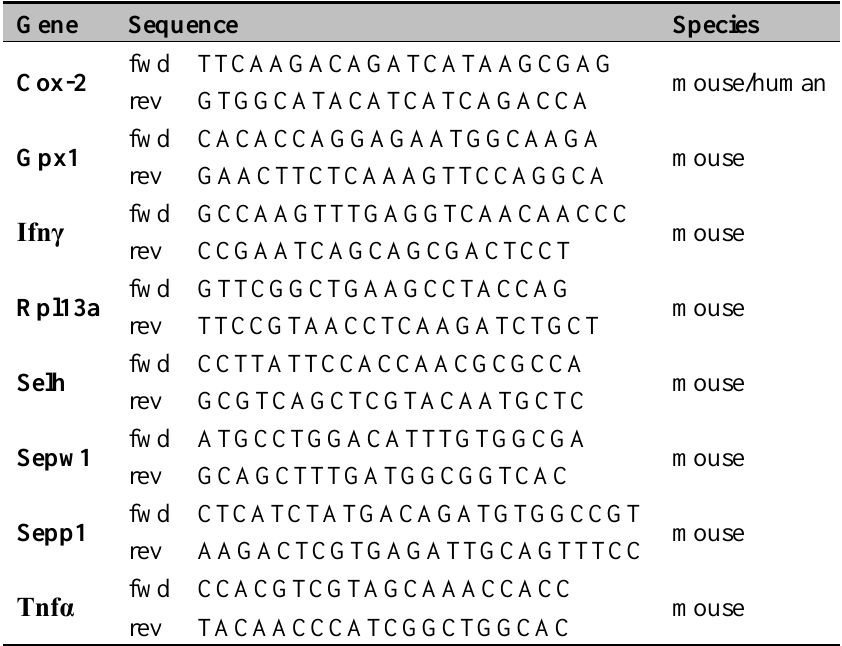
Table 1. Primer sequences